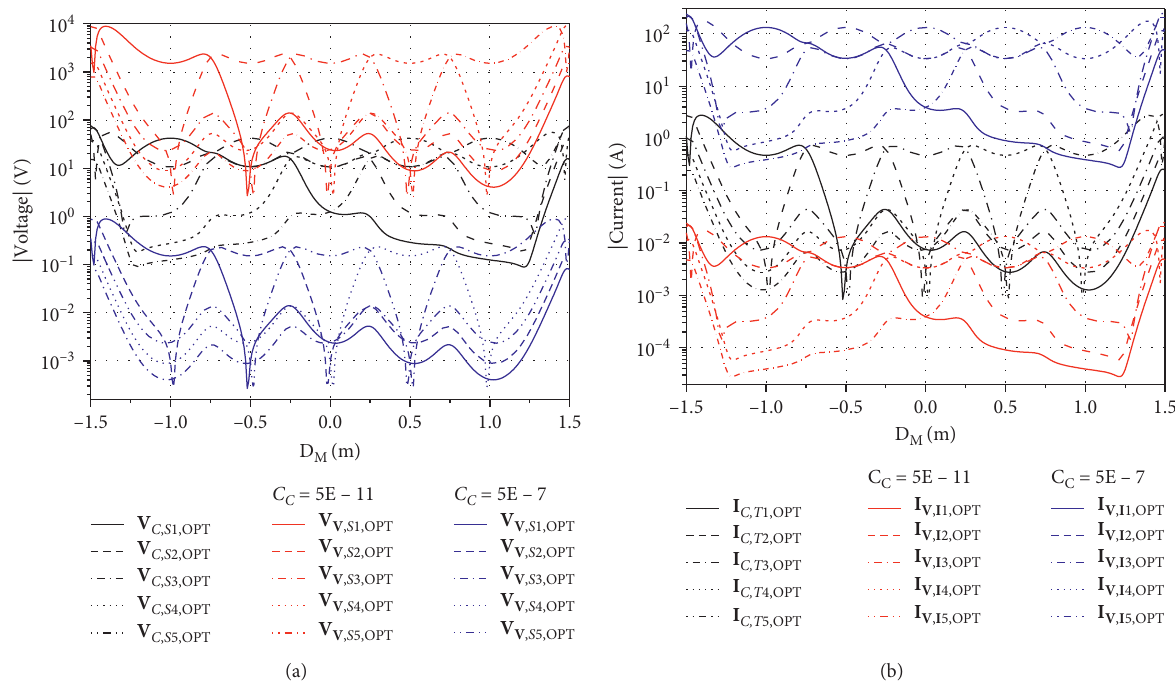
Figure 6: Comparison of source voltage and feeding current between OC and OE Case for 5-TX system when D Optimal voltage and (b) current for maximizing PDL.